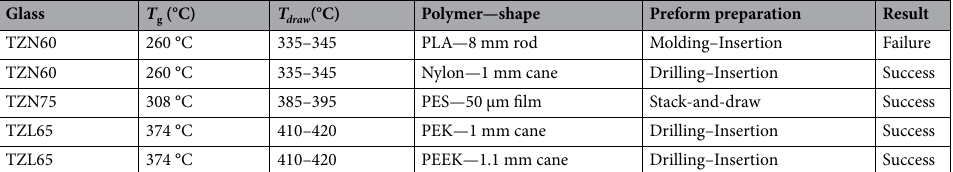
Glass T g (°C) T draw